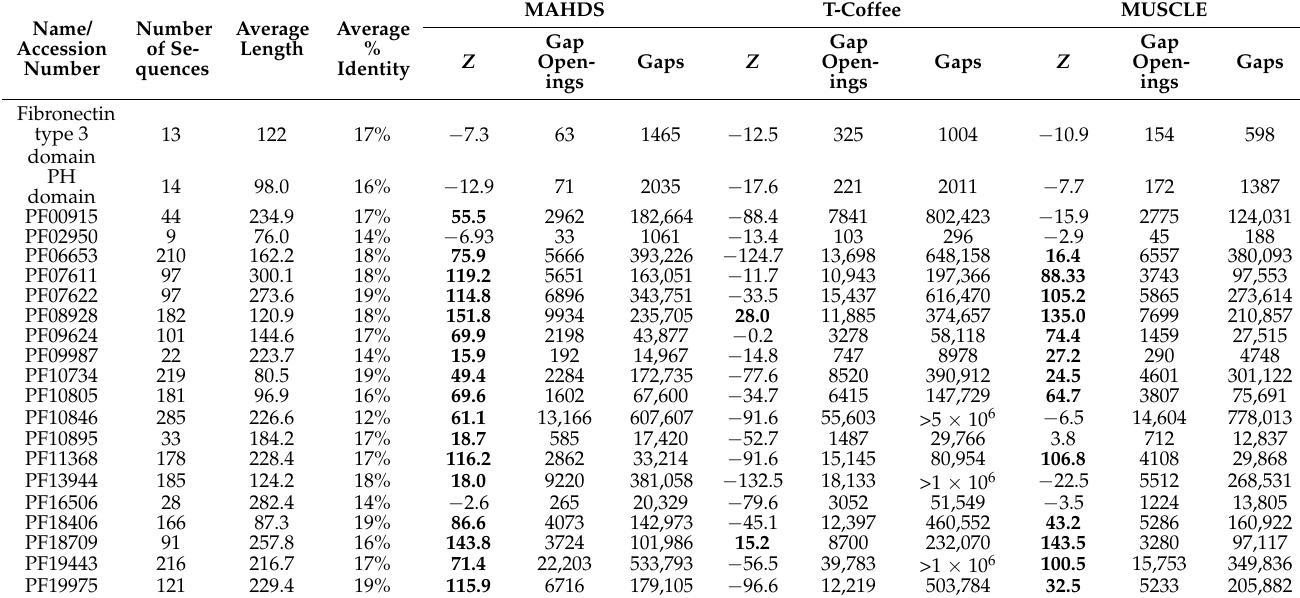
Table 7. Performance of MAHDS, T-Coffee, and MUSCLE in building MSAs of low identity protein families ( Z values > 10.0 are in bold). The first two families are taken from https://mizuguchilab.